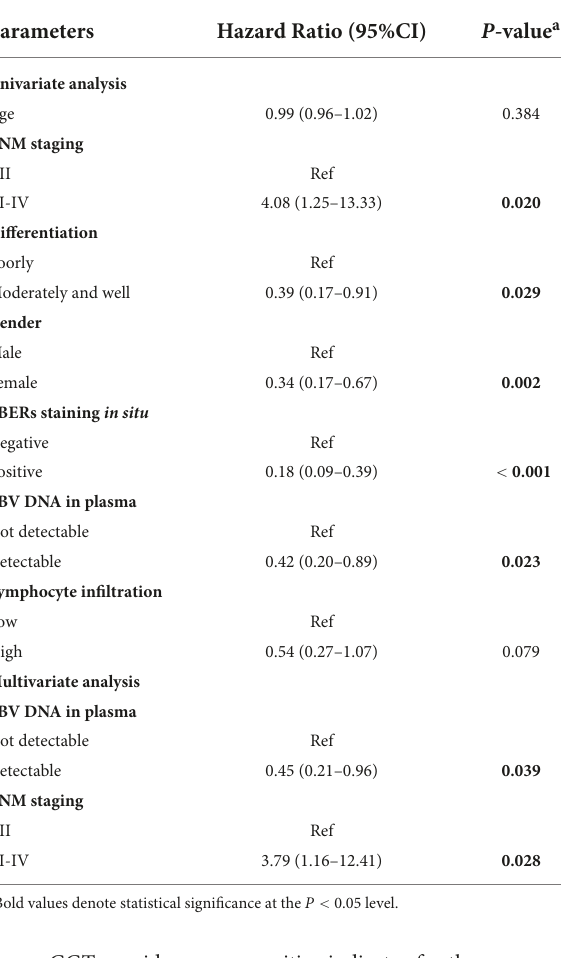
TABLE 7 Univariate and multivariate analyses for the overall survival in gastric cancer patients.